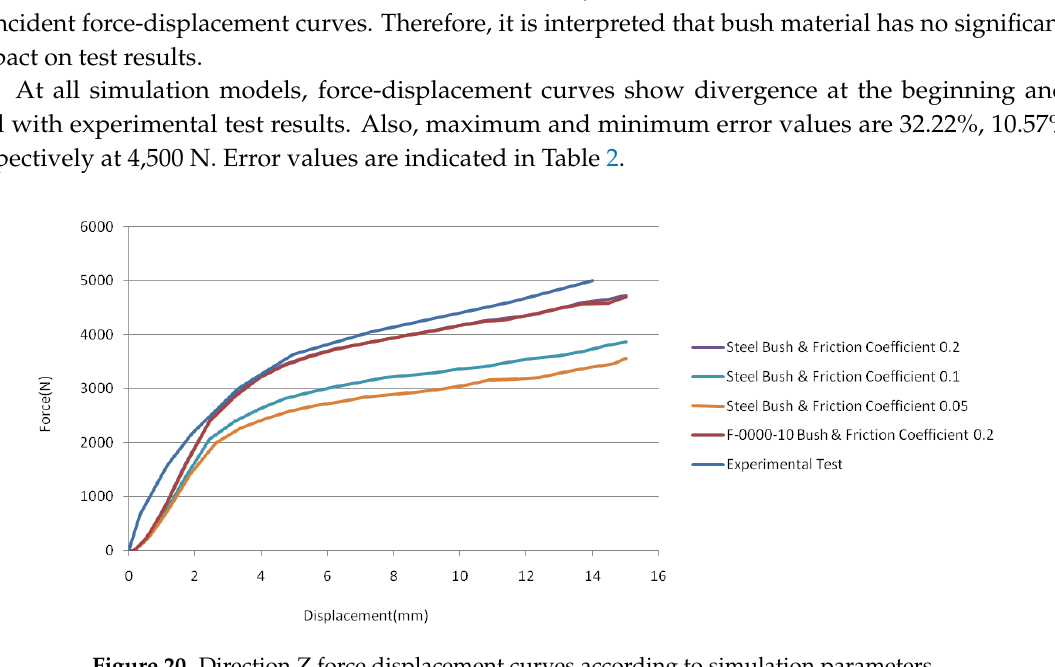
Figure 20. Direction Z force displacement curves according to simulation parameters.